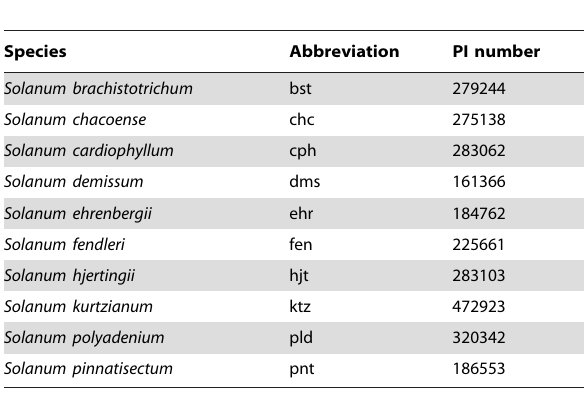
Table 1. Wild potato species used for amplification of RB homologous CC